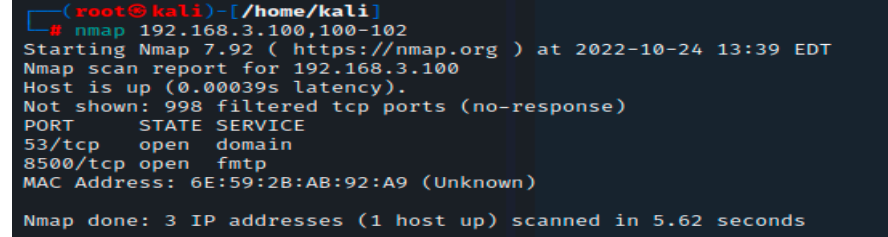
Figure 3. Nmap scan for open ports.